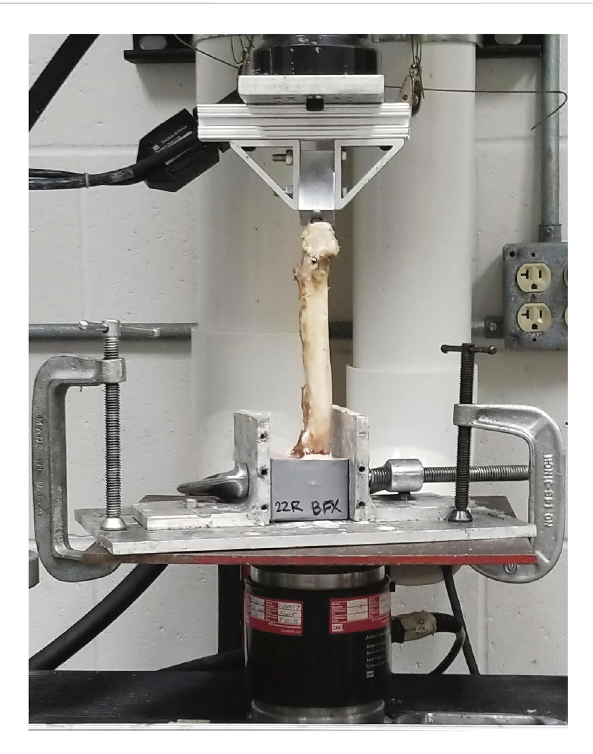
FIGURE 3 Axial torsion fi xture loaded with potted right femur with implanted BFX + lb, prepared for testing in the MTS machine. The lateral aspect of the femur is facing the camera and the lateral protruding portion of the lateral bolt is visualized caudolaterally, just distal to the greater trochanter. The cranial aspect of the femur is to the right of the